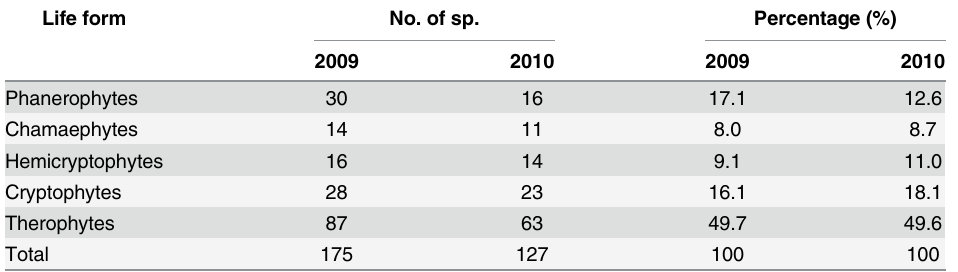
Table 4. Comparison of the absolute number and percentage of each life form category in the draw- down area before impoundment by the Three Gorges Dam and after impoundment in both 2009 and 2010. Data for 2009 are taken from 12 of the 14 sites as previously reported in [13]. Life form No. of sp. Percentage (%)